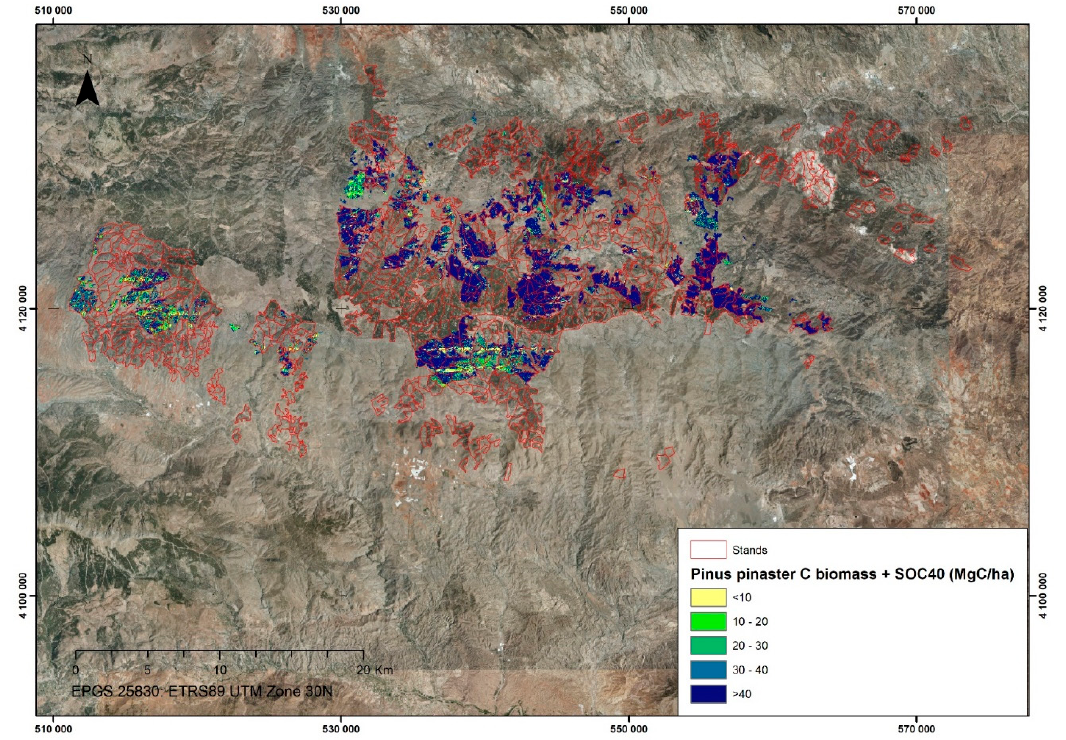
Figure 6. Cartography of the C stocks in Pinus pinaster plantations at Sierra de los Filabres (Southern Spain).